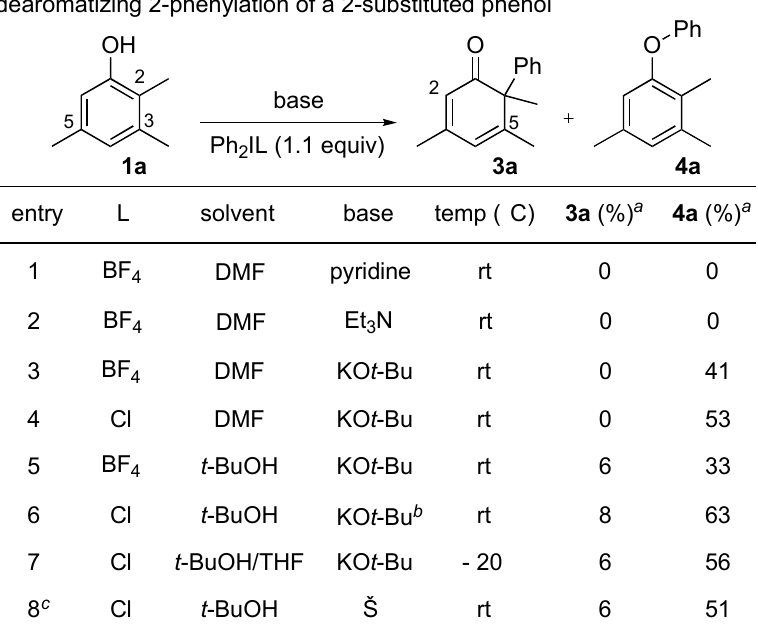
Table 1. Preliminary search of reaction conditions to